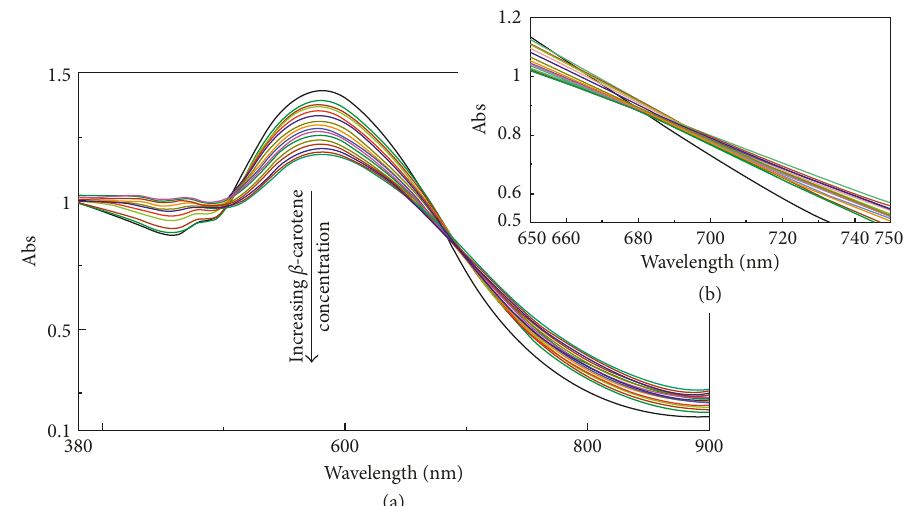
Figure 3: Overlapped UV-Vis spectra of the successive adding of β -carotene solution to the MnTTPCl/n-Au hybrid (a). Details of the isosbestic point at 685nm